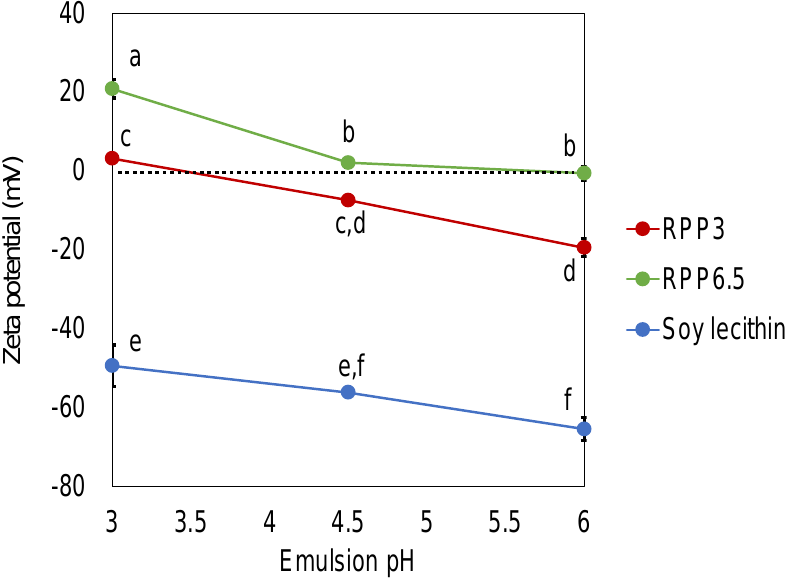
Figure 2. Zeta potential of emulsions with varying pH, stabilized by rapeseed protein precipitated at pH 3 (RPP3) and pH 6.5 (RPP6.5) and soy lecithin. Data is an average from four measurements for each formulation. Different letters indicate significant differences between the data points, p < 0.05.